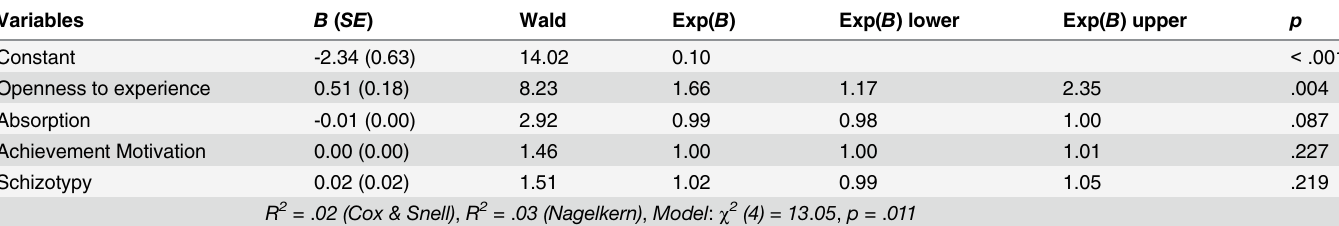
Table 3. Results of the binary logistic regression with simultaneous entry (SE in parentheses).